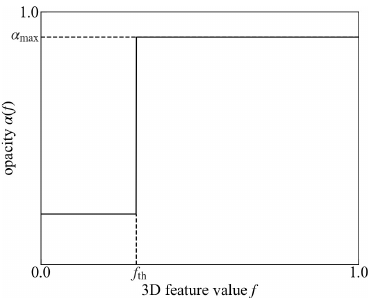
Figure 2. Typical relation between 3D feature value f and opacity α when adopting the function of type (a). The relation has the step-functional feature, and f th is the user-defined threshold value that defines the stepping